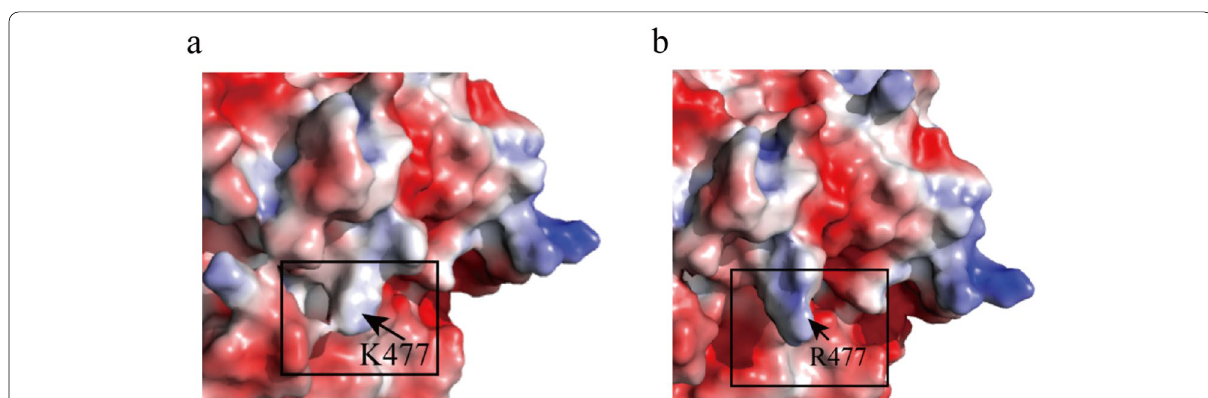
Fig. 8 Comparison of the electrostatic surface around residue 477. a The wild-type CadA. b The K477R mutant. Blue means positive charge, while red means negative charge